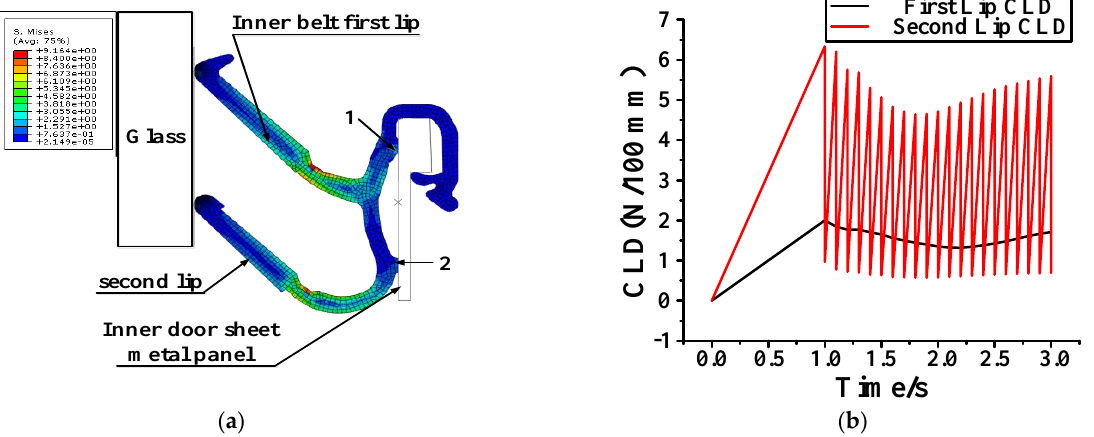
Figure 21. Simulation analysis. ( a ) Pressure load of automobile window; ( b ) inner belt of falling glass.